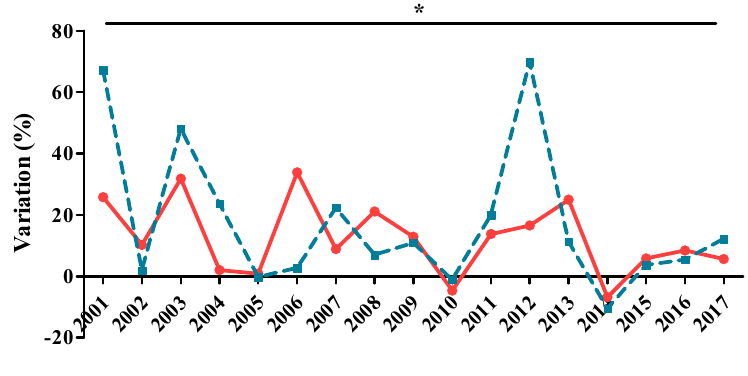
Figure 2. Adjusted growth rate of diabetes mellitus (DM) funds (DMF) compared to National Unique Fund of Social Health Insurance for Health Programmes (NUFSHI HP) (2000–2017). (r = 0.488, * p = 0.047).